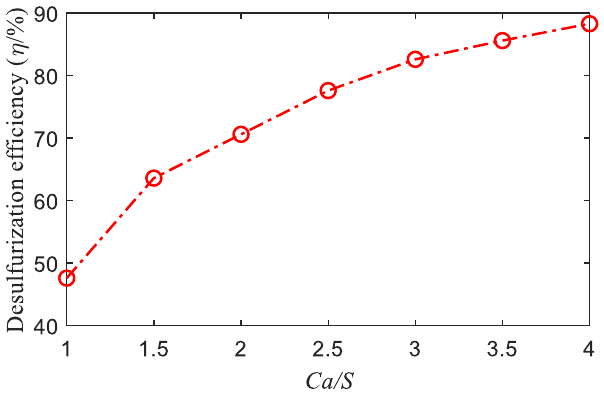
Figure 4. The effect of calcium to sulfur ratio on desulfurization efficiency.